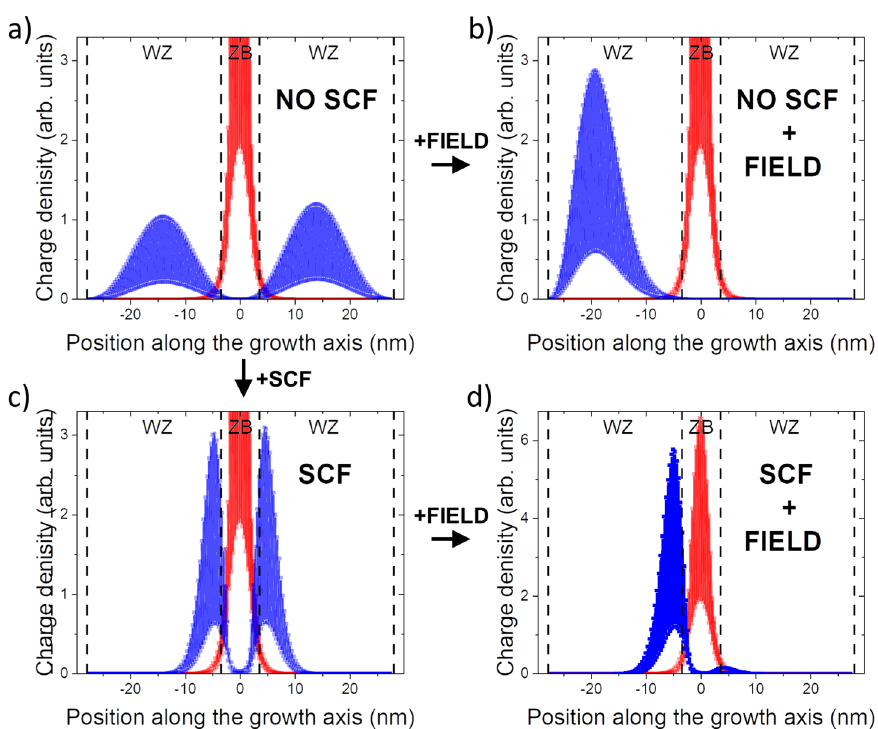
Figure 2. The charge density of ground hole (blue) and ground electron (red) states calculated for a CPQD of H = 4 nm and D = 23.5 nm, for several different cases: ( a ) with no electron-hole interaction, ( b ) with no electron-hole interaction and an external electric field forming a well for holes at the edge of the computational box, ( c ) with electron-hole interaction accounted for via self-consistent approach discussed in the text, ( d ) with electron-hole interaction and external-field taken on equal footing. The electron state remains virtually identical in all cases. Note different vertical scales ( a – c ) that truncate the top of the electron peak for better hole state visualization. Vertical dashed lines mark the edges of WZ